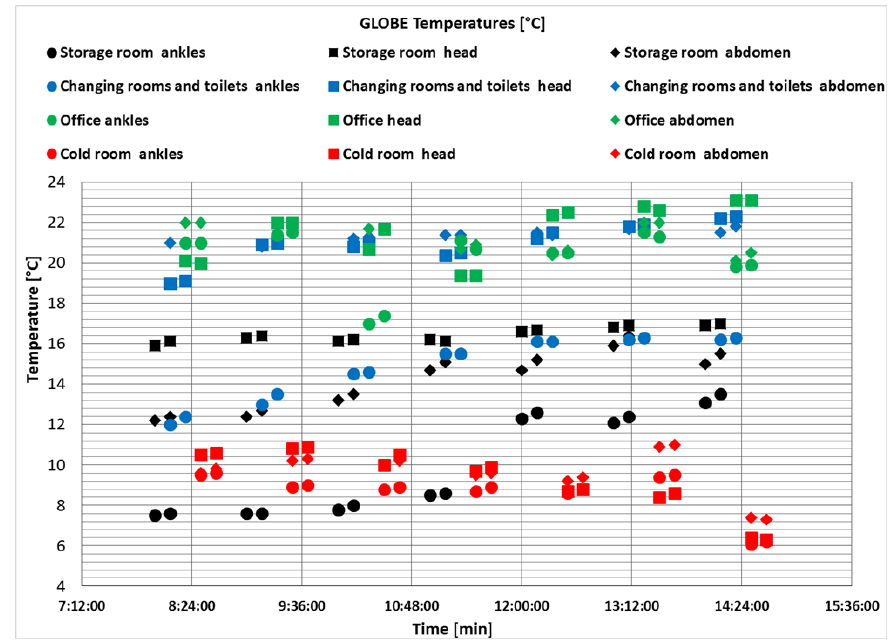
Figure 6. Average temperature values measured by a globe thermometer in the food storage area, in the o ffi ce, in changing room and in a cold room